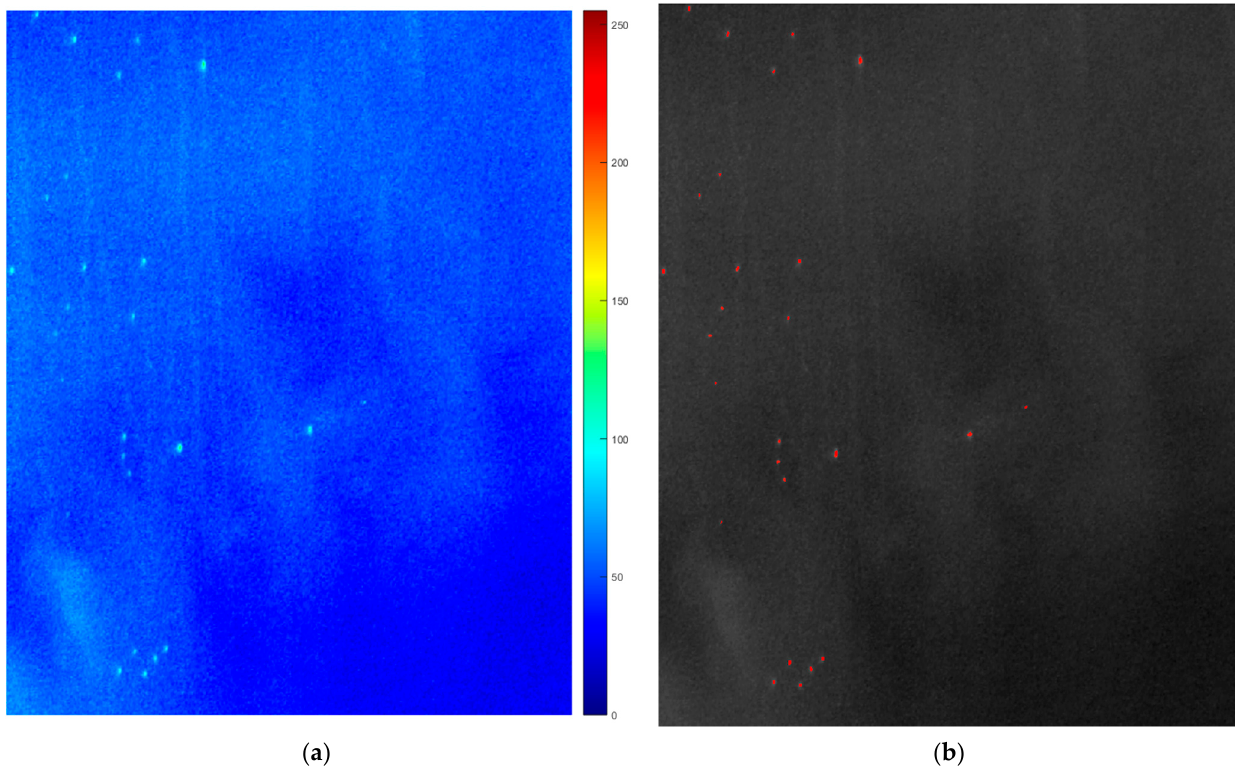
Figure 8. Locally enlarged result of preliminary ship detection in the NIR band: ( a ) local view of NIR band; ( b ) detection result in the NIR band.